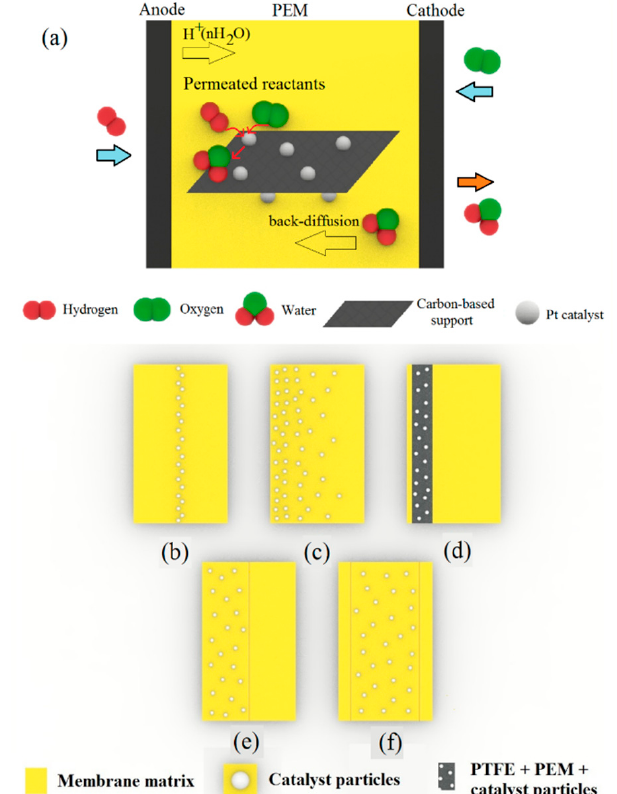
Figure 6. Schematic presentation of ( a ) a self-humidifying PEM endowed with Pt nanoparticles anchored upon carbon-based supports for better dispersion, ( b ) Pt-sputtered layer between two plain PEM layers, ( c ) gradationally dispersed Pt nanoparticles within the PEM, ( d ) a PTFE-supported Pt–C/Nafion layer near the anode, ( e ) a two-layer composite PEM with a self-humidifying layer near the anode, and ( f ) a three-layer nanocomposite membrane with a central self-humidifying layer.